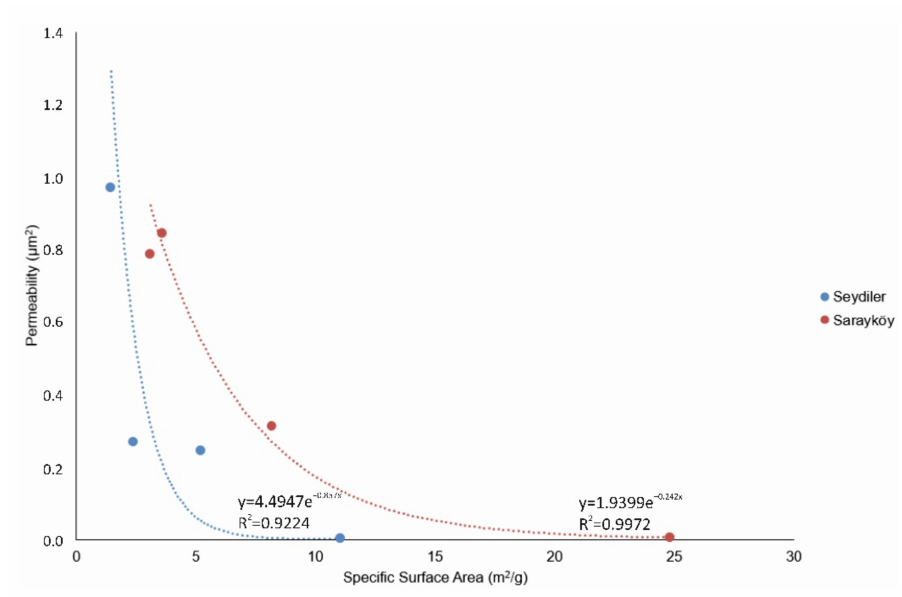
Figure 9. Permeability versus specific surface area graph for diatomite samples.